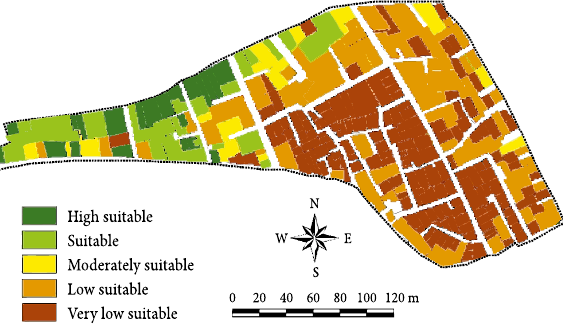
Fig. 3. Final map for the best leisure space in the blighted